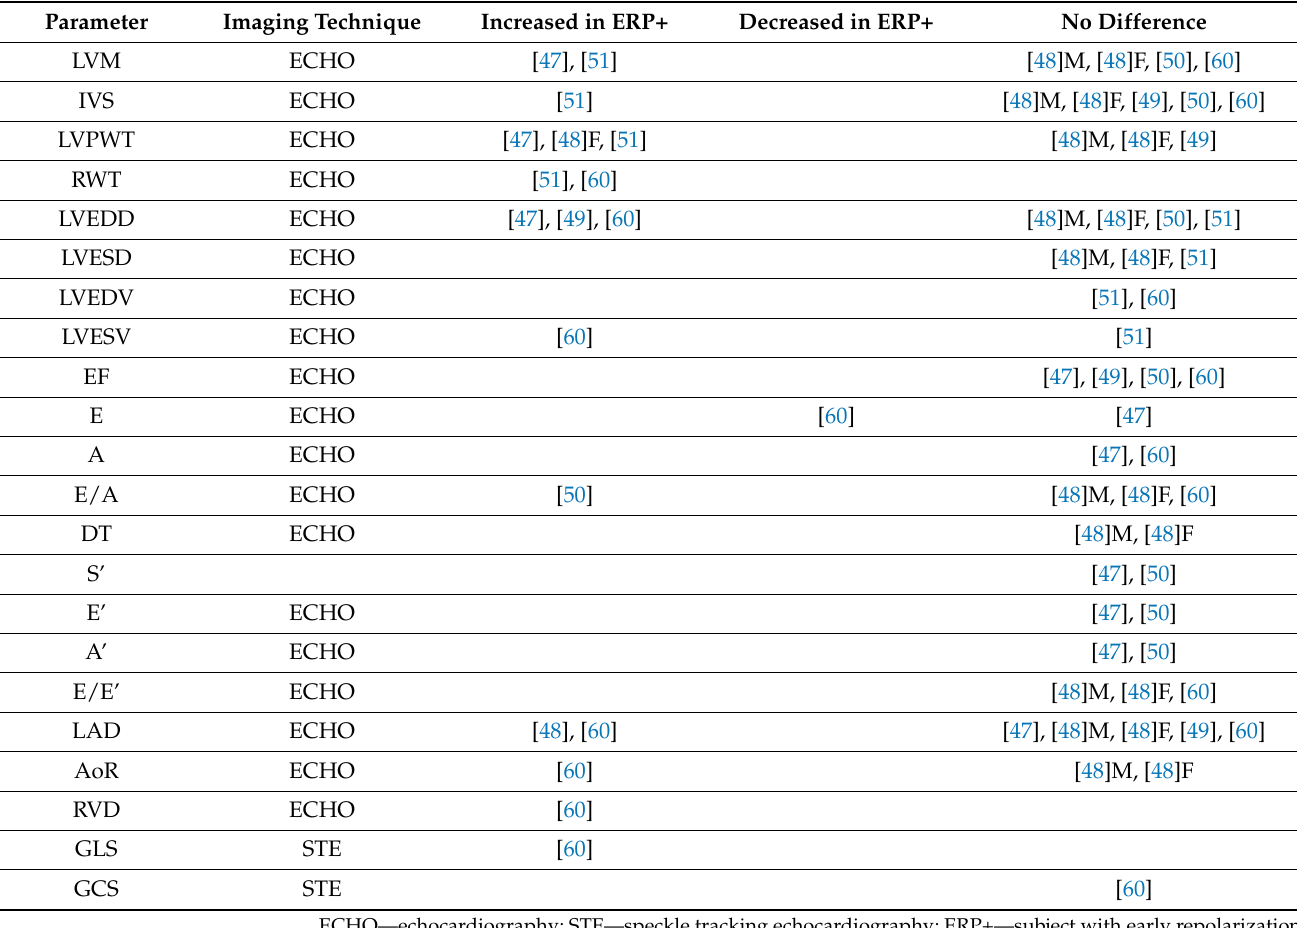
Table 4. The main cardiac morphological and functional parameters investigated in different studies performed on athletes. Differences between the ERP+ and ERP- individuals. The reference of the study is indicated in the square bracket, the M and F after the brackets denote the male and female